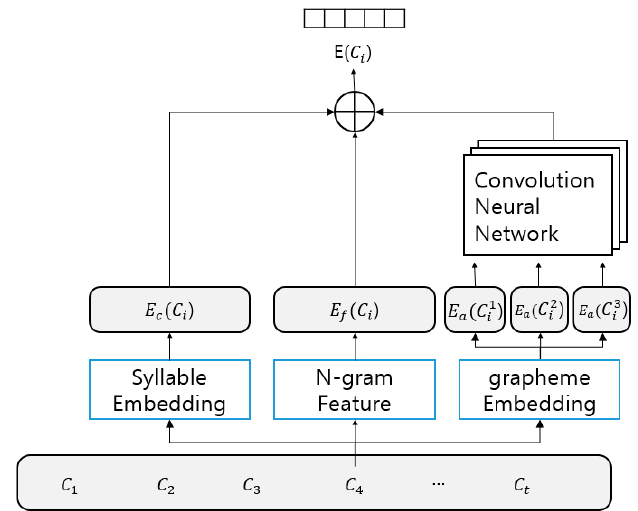
Figure 2. Input unit of MANE.